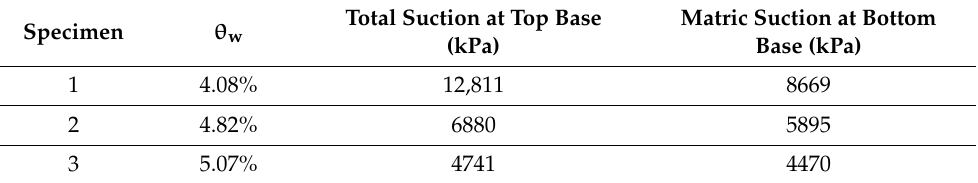
Table 6. Suction values inferred by i.c.f.p.m. and n.i.c.f.p.m., on three oedometric shaped specimens, adopting calibration curve (Equations (4) and (5), from [41]) for Whatman N ◦ 42 filter paper. Total Suction at Top Base Matric Suction at Specimen θ w (kPa)